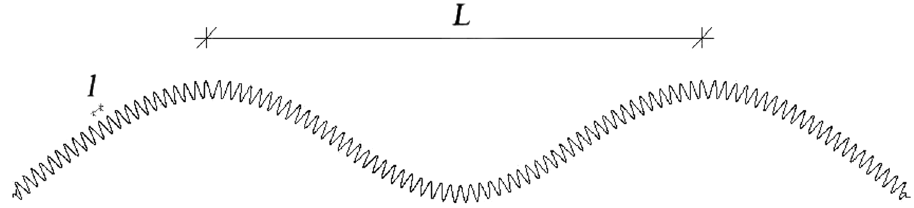
Fig. 3 Scheme of wave motion while reducing wave energy during the process of ripple formation on its surface